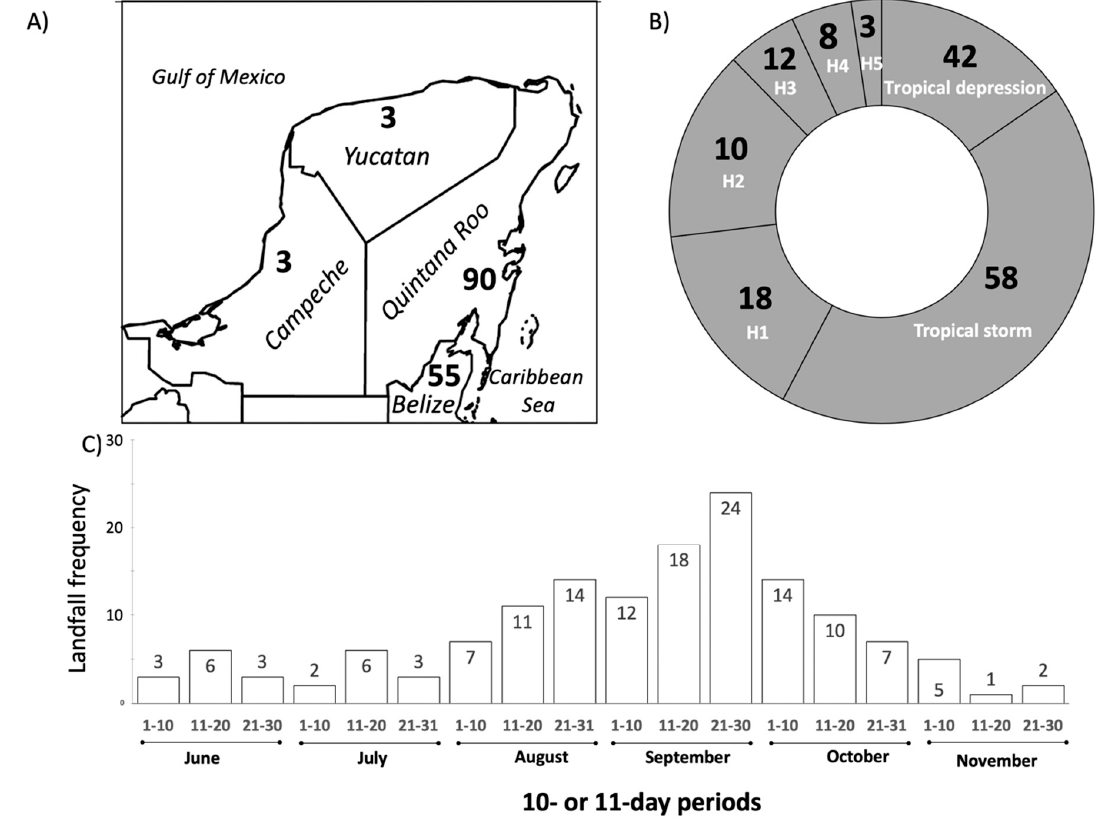
Figure 4. Tropical cyclone frequency (N = 151) in the Yucatan Peninsula from 1851–2019. ( A ) Number of tropical cyclones crossing per state in the Yucatan Peninsula; ( B ) Storm intensity frequency per category at landfall; ( C ) Monthly landfall frequency from June to November.